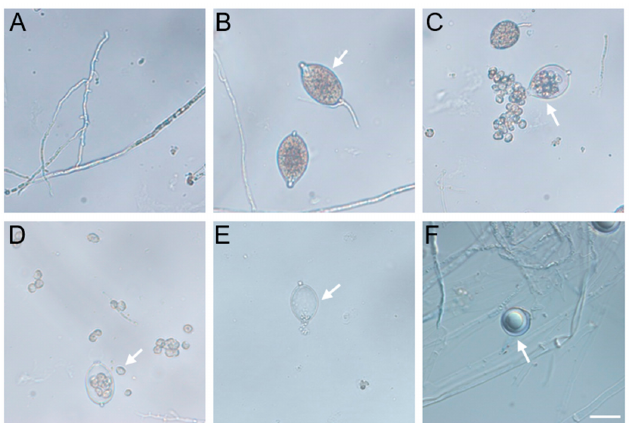
Figure 1. Morphological characteristics of Phytophthora cactorum . ( A ) Morphology of hyphae. ( B ) Pyriform sporangia. ( C ) Sporangia that are releasing zoospores. ( D ) Zoospores. ( E ) Empty sporangium. ( F ) Oospore. Arrows indicate morphological characteristics. Scale bars: 40 μ m.